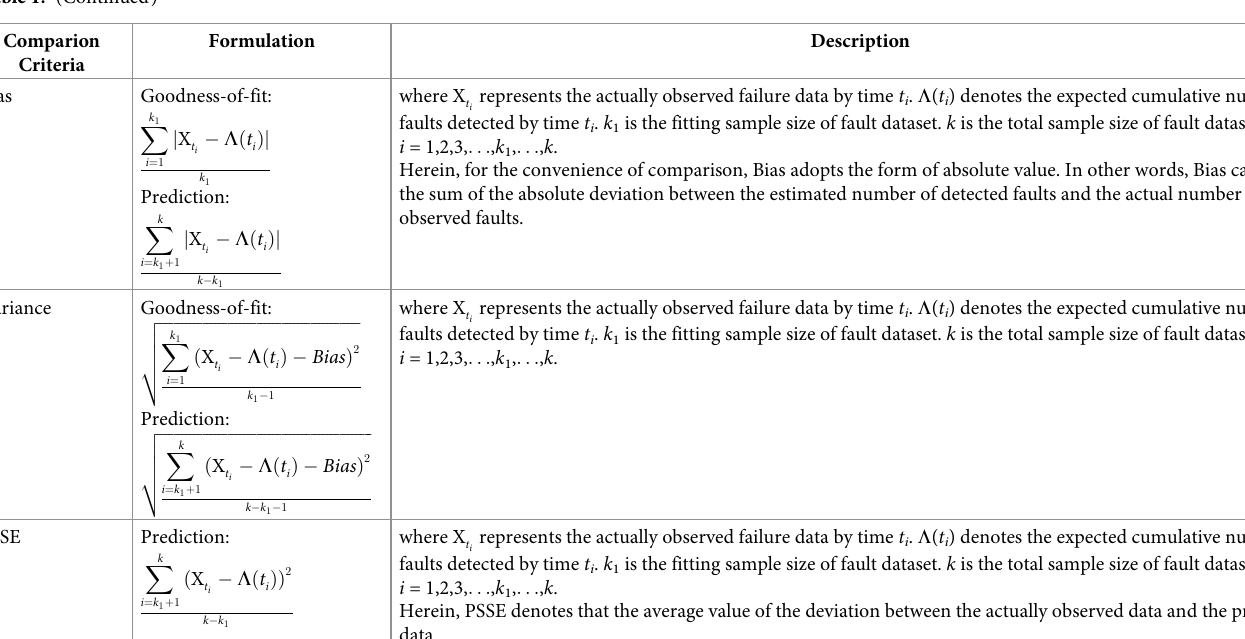
where X represents the actually observed failure data by time t i . Λ ( t i ) denotes the expected cumulative number of t i faults detected by time t . k 1 is the fitting sample size of fault dataset. k is the total sample size of fault dataset. i i = 1,2,3, ... , k 1 , ... , k . Herein, PSSE denotes that the average value of the deviation between the actually observed data and the predictive data.